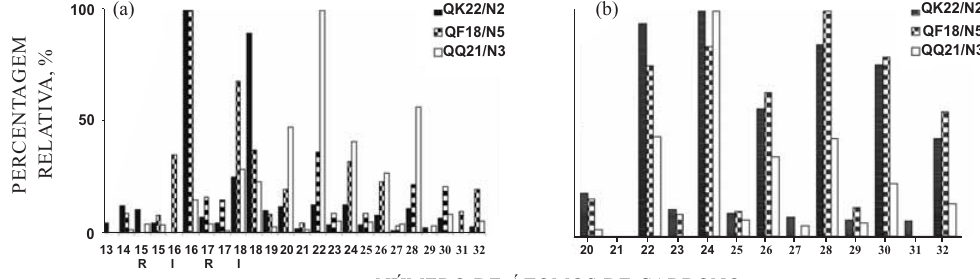
Figura 2. Histogramas da distribuição percentual de compostos ácidos (a) e álcoois (b) de amostras de sedimento dos três contextos do Sítio Arqueológico do Rio do Meio, Ilha de Santa Catarina, SC. R: compostos ramificados (iso e anteiso) e I: compostos